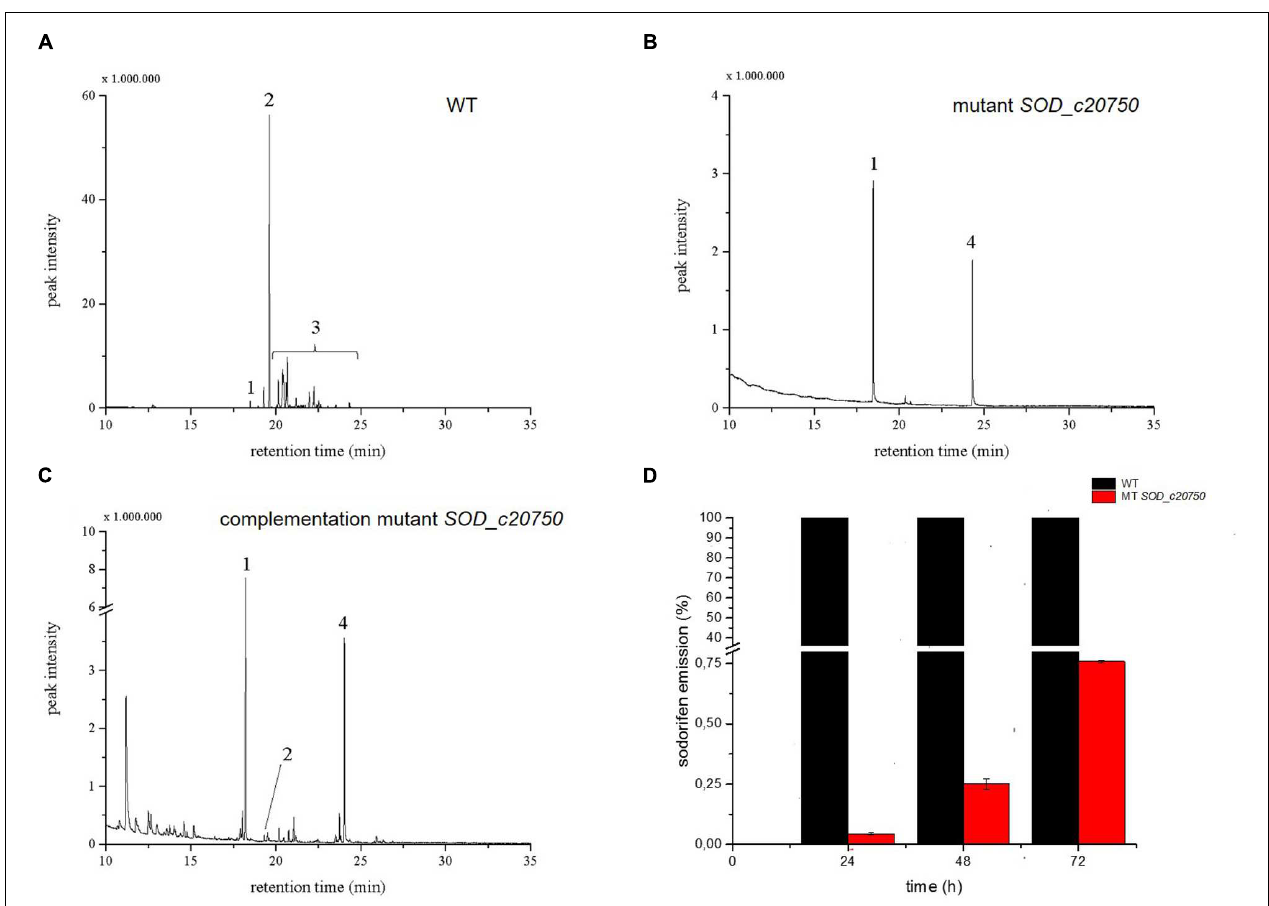
FIGURE 4 | Analysis of the SOD_c20750 (terpene cyclase) knockout and complemented mutant of Serratia plymuthica 4Rx13. Typical volatile organic compound (VOC) profiles of the headspaces of the wild type (A) , the SOD_c20750 mutant (B) and the complemented mutant (C) grown in complex medium (NB) in a VOC collection system. VOCs were trapped in the time interval 24–48 h. The compounds were analyzed by GCMS and identified by comparing their mass spectra with those of the Nist107 library. (#1) nonyl acetate was internal standard (peak corresponds to 5 ng), (#2) sodorifen, (#3) sodorifen isomers, (#4) new compound. (D) The emission of the complemented SOD_c20750 mutant (red) at different time points is plotted against the wild type (black), wild type equals 100%. (100% equals 274 ng of sodorifen emission or 12.21 ag sodorifen emission/cell). The peak intensity in the complemented mutant equals 0.70 ng sodorifen emission ( = 0.03 ag/cell). The knockout mutant did not emit sodorifen and was omitted from the graphic presentation. Error bars indicate min/max values of two clones of one complementation experiment. The emission of sodorifen was restored by introducing a recombinant plasmid consisting of the plasmid pUC19, the wild type gene SOD_c20750 and the 500 bp upstream region of the SOD_c20780